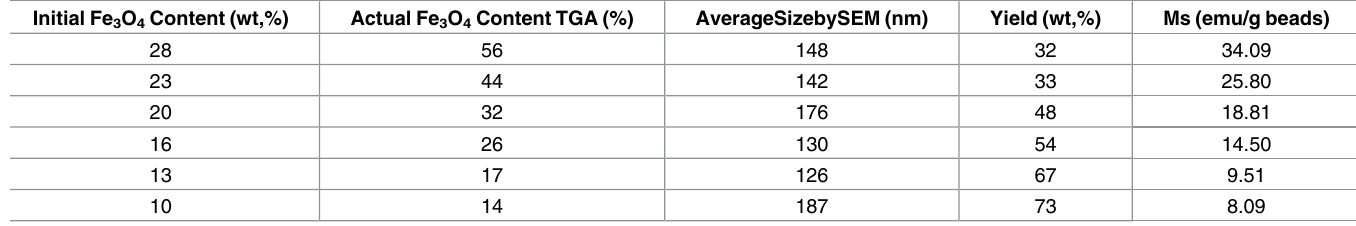
Table 2. Characteristics of magnetic beads, including Fe 3 O 4 content (TGA,wt%); average diameter (SEM); Yield(wt%) and saturation magnetiza- tion (Ms). Initial Fe 3 O 4 Content